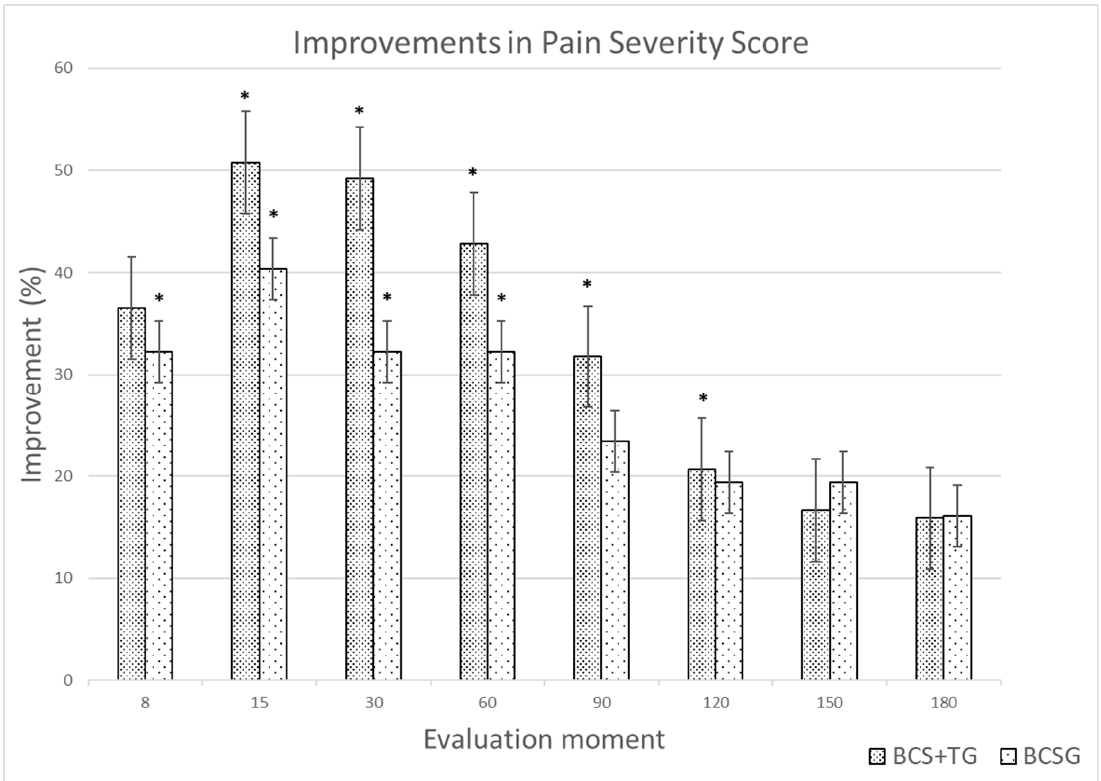
Figure 2. Improvements (%) in Pain Severity Score for the Blood Cell Secretome + triamcinolone group (BCS+TG) and the Blood Cell Secretome group (BCSG), compared to baseline values. * indicates a clinically significant improvement (reduction ≥ 1).